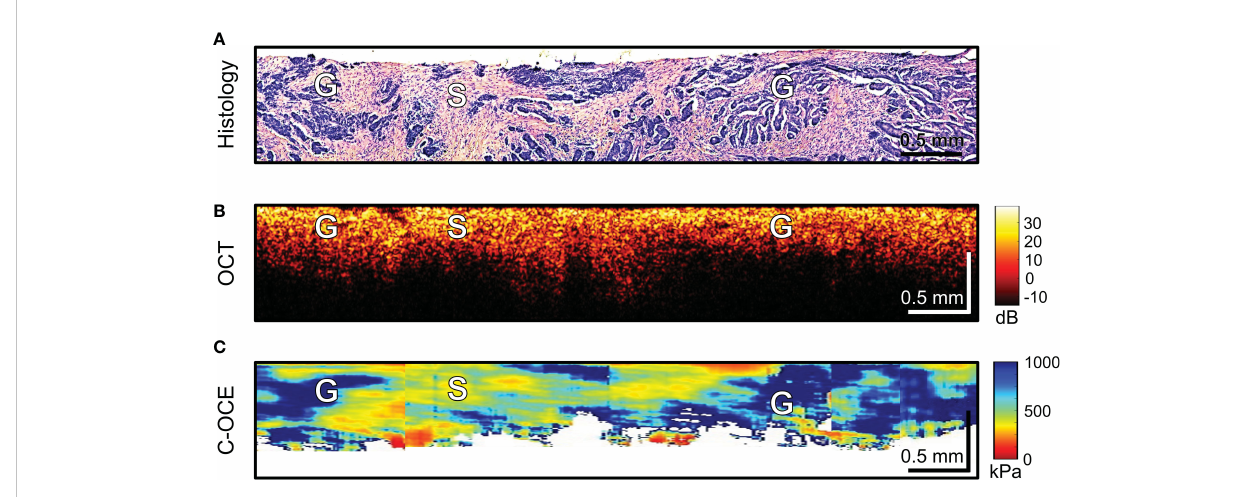
FIGURE 6 Example of morphological examination of low-grade colorectal adenocarcinoma (low-grade CRAC) tissues by C-OCE: stiffness values of tumorous stroma [S] are lower (295 ± 120 kPa) than in gland-like structures [G] (724 ± 86 kPa). Heterogeneity in the spatial distribution of this two tissue types is observed. Corresponding tissue areas in histological (A) , OCT (B) and C-O С E (C) images. Bar size is shown in the